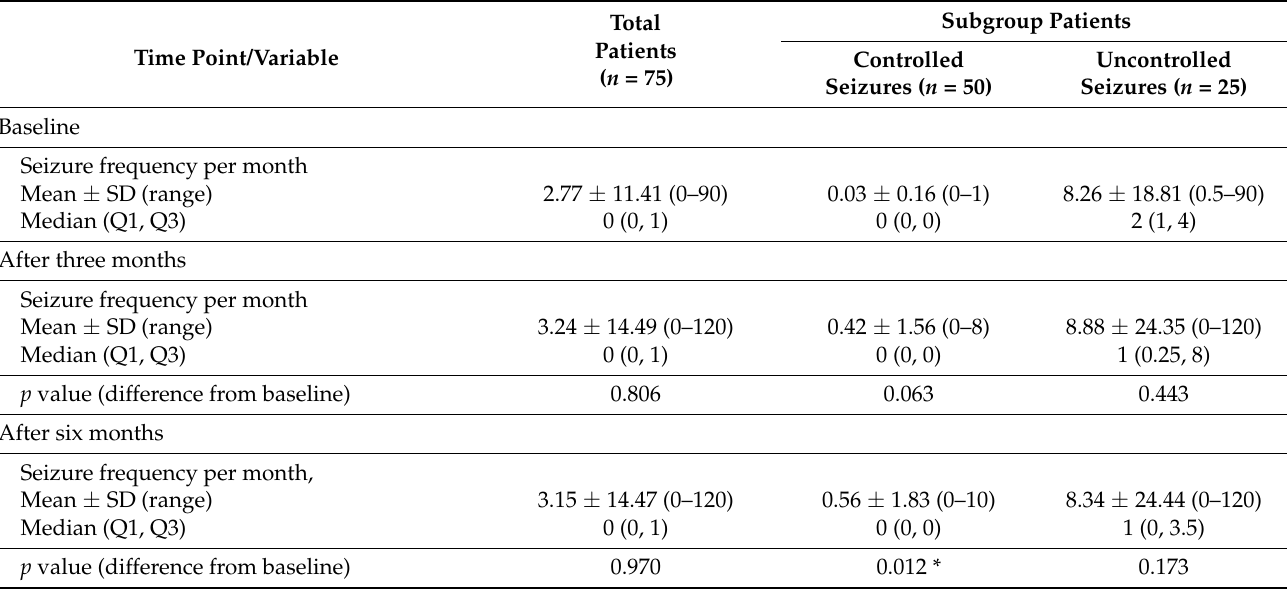
Table 3. Clinical characteristics of total patients and patient